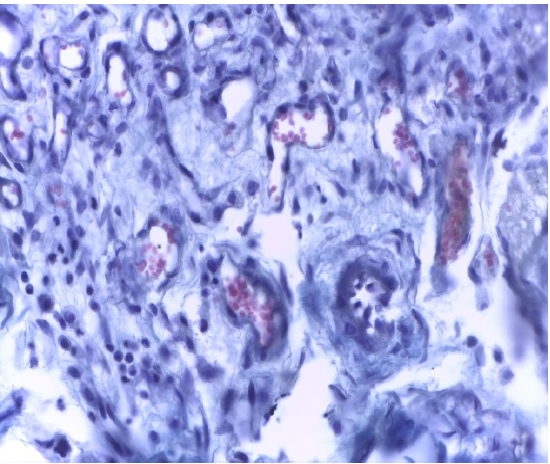
Figure 11. Group A. Scar tissue and rare inflammatory cells at the implant site with MTA after 30 days. Rare inflammatory cells. Col. Trichrome Masson, ×400 .